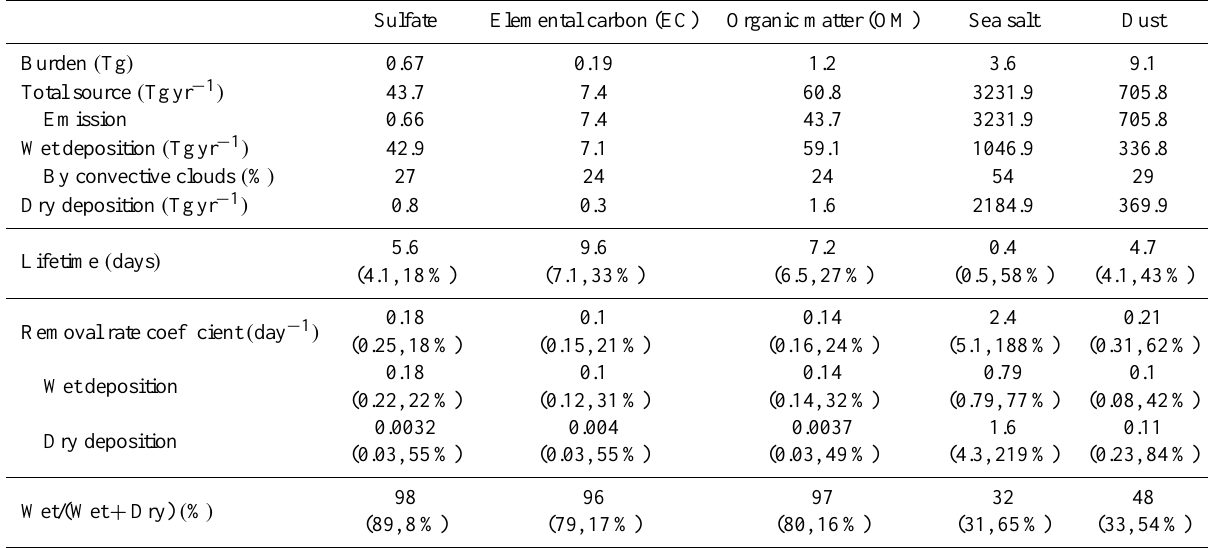
Table 4. Global aerosol budgets of the BASE run in ModelE2-TOMAS. Values in the parentheses are the mean and normalized standard deviations obtained from Table 10 in Textor et al. (2006). The mass budgets for sulfate are presented as TgS.